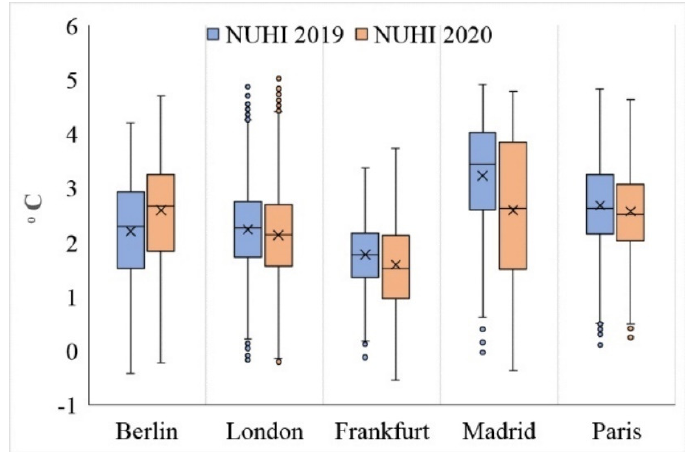
Figure 9. NUHI characteristics in the studied cities during 2019 (blue) and 2020 (red).